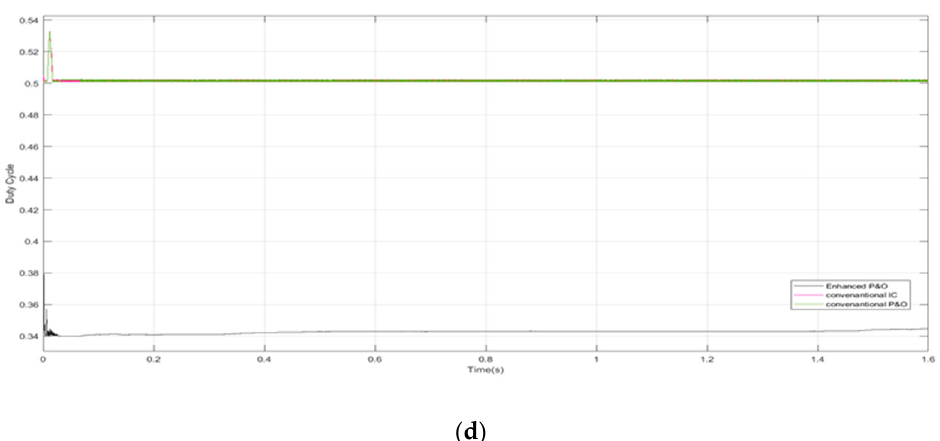
Figure 20. ( a ) Scenario of case “d” of the (4S) PV array; ( b ) The extracted power by the proposed technique and the conventional P&O and IC techniques; ( c ) The voltage at the boost converter output; ( d ) The duty cycle behaviors.